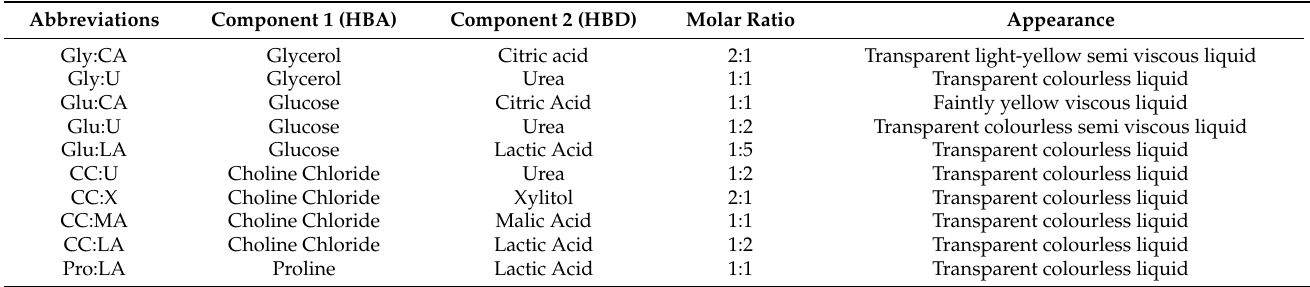
Table 1. Composition of natural deep eutectic solvents (NADES) used in this study and details concerning the synthesis thereof.